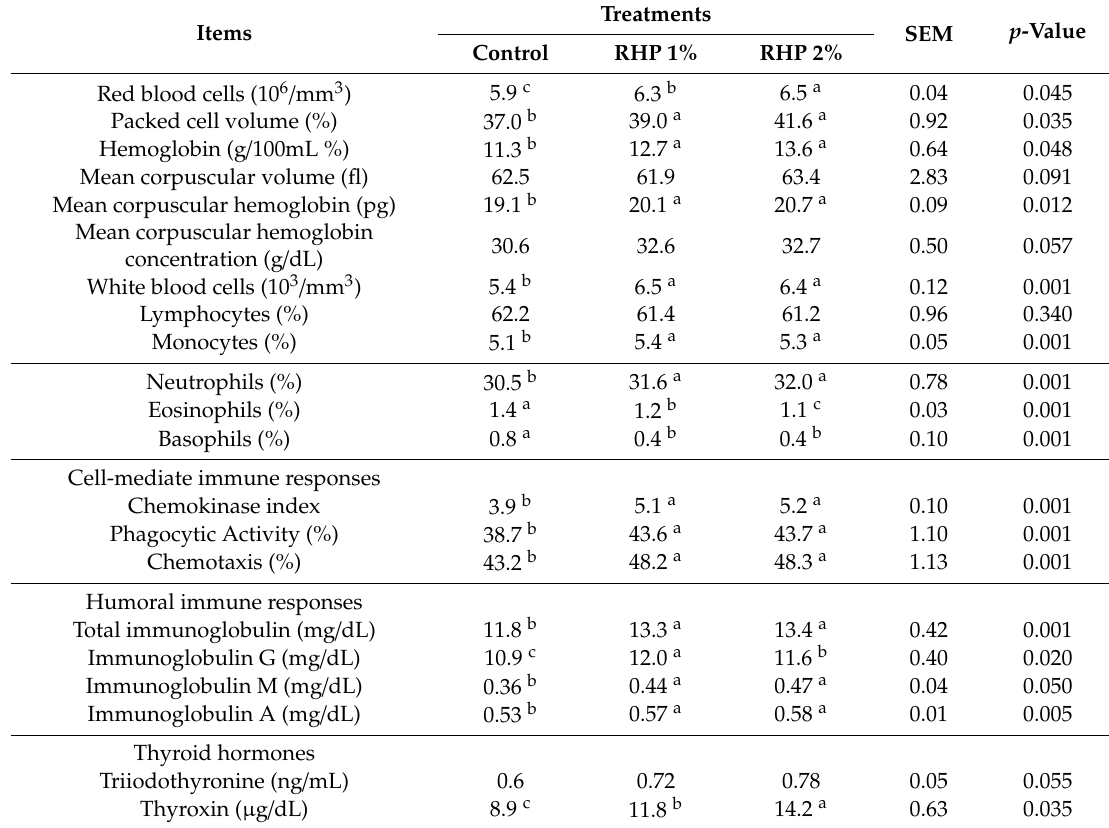
Table 4. Hematology, immunological responses, and thyroid hormone levels of New Zealand